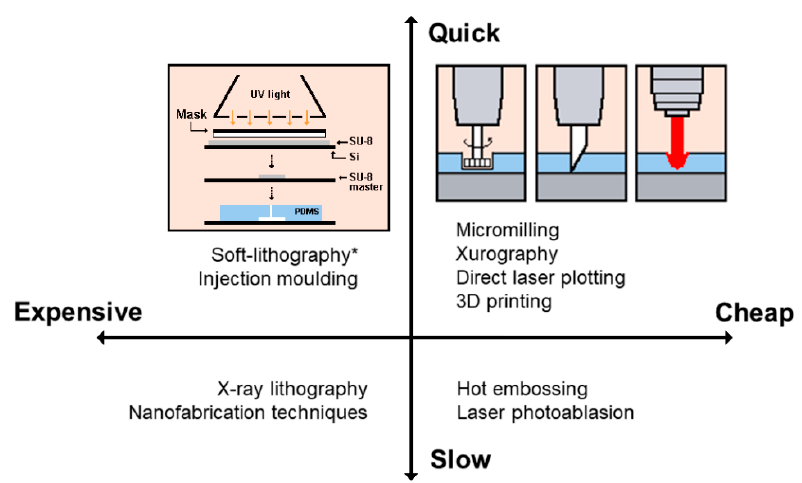
Figure 4. Fabrication techniques from a time and cost perspective. Adapted from [14]. * Despite standard soft-lithography technique is considered expensive, new alternatives without the need of cleanroom facilities significantly drop the cost, being considered as low-cost, as the work published by Pinto et al., 2014 [21]. Table 2. Significant characteristics of the most common materials used for biomedical applications. Adapted from